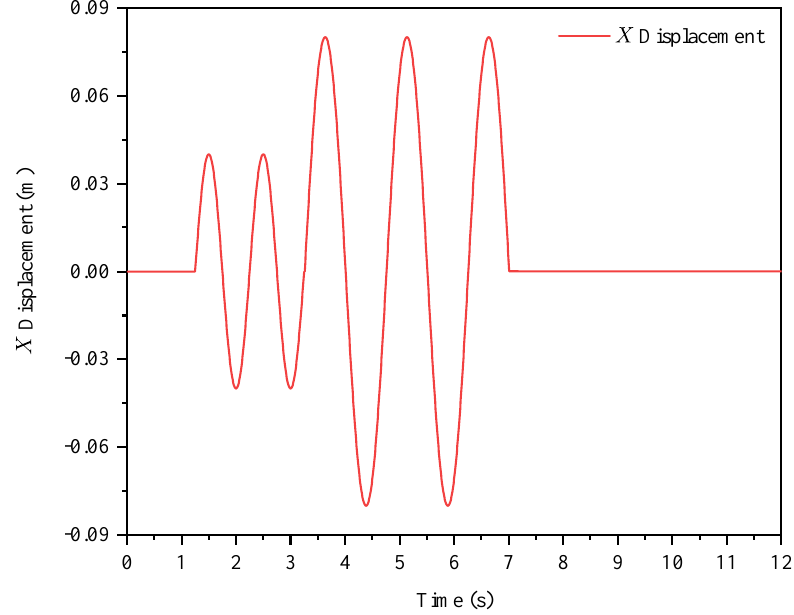
Figure 3. Profile of the piston signal given to the wave-making boundary Γ 1 for Example 1, which starts from t = 1.25s and ends at t = 7.0s.